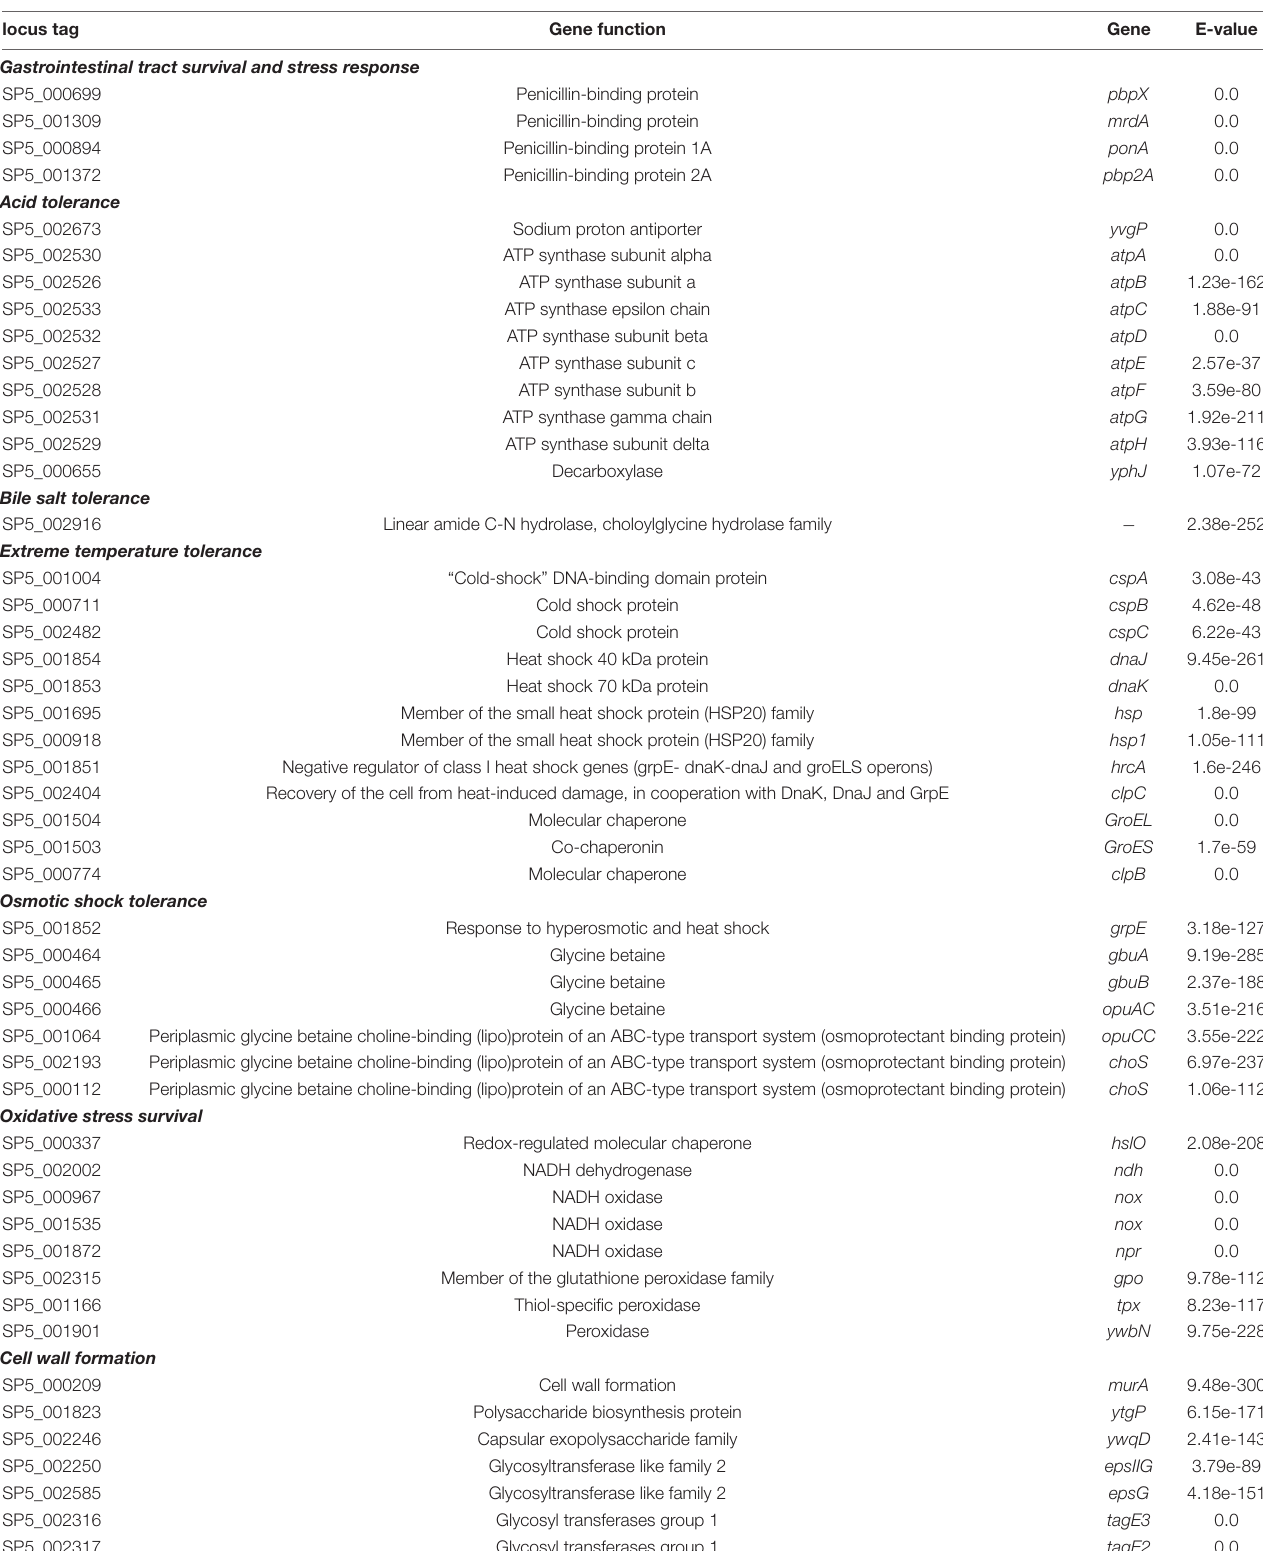
TABLE 3 | Annotation of genes coded by Lc. paracasei SP5 that are implicated in stress response and host-microbe interactions. locus tag Gene function Gene